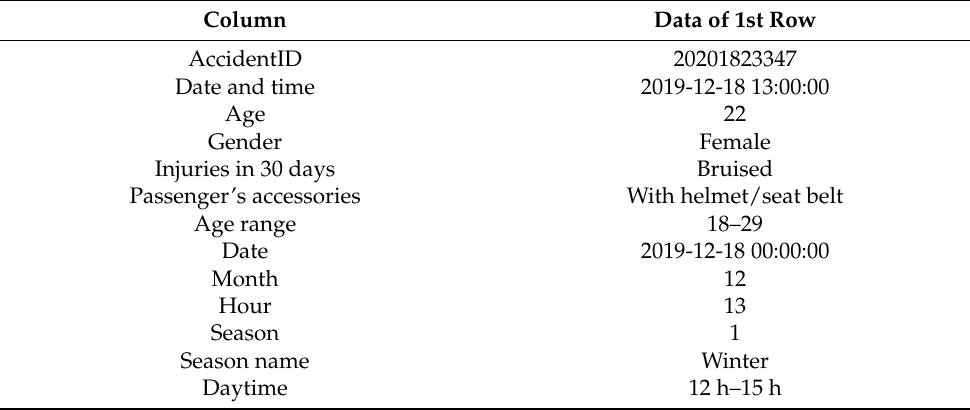
Table 12. Passengers involved data schema after data